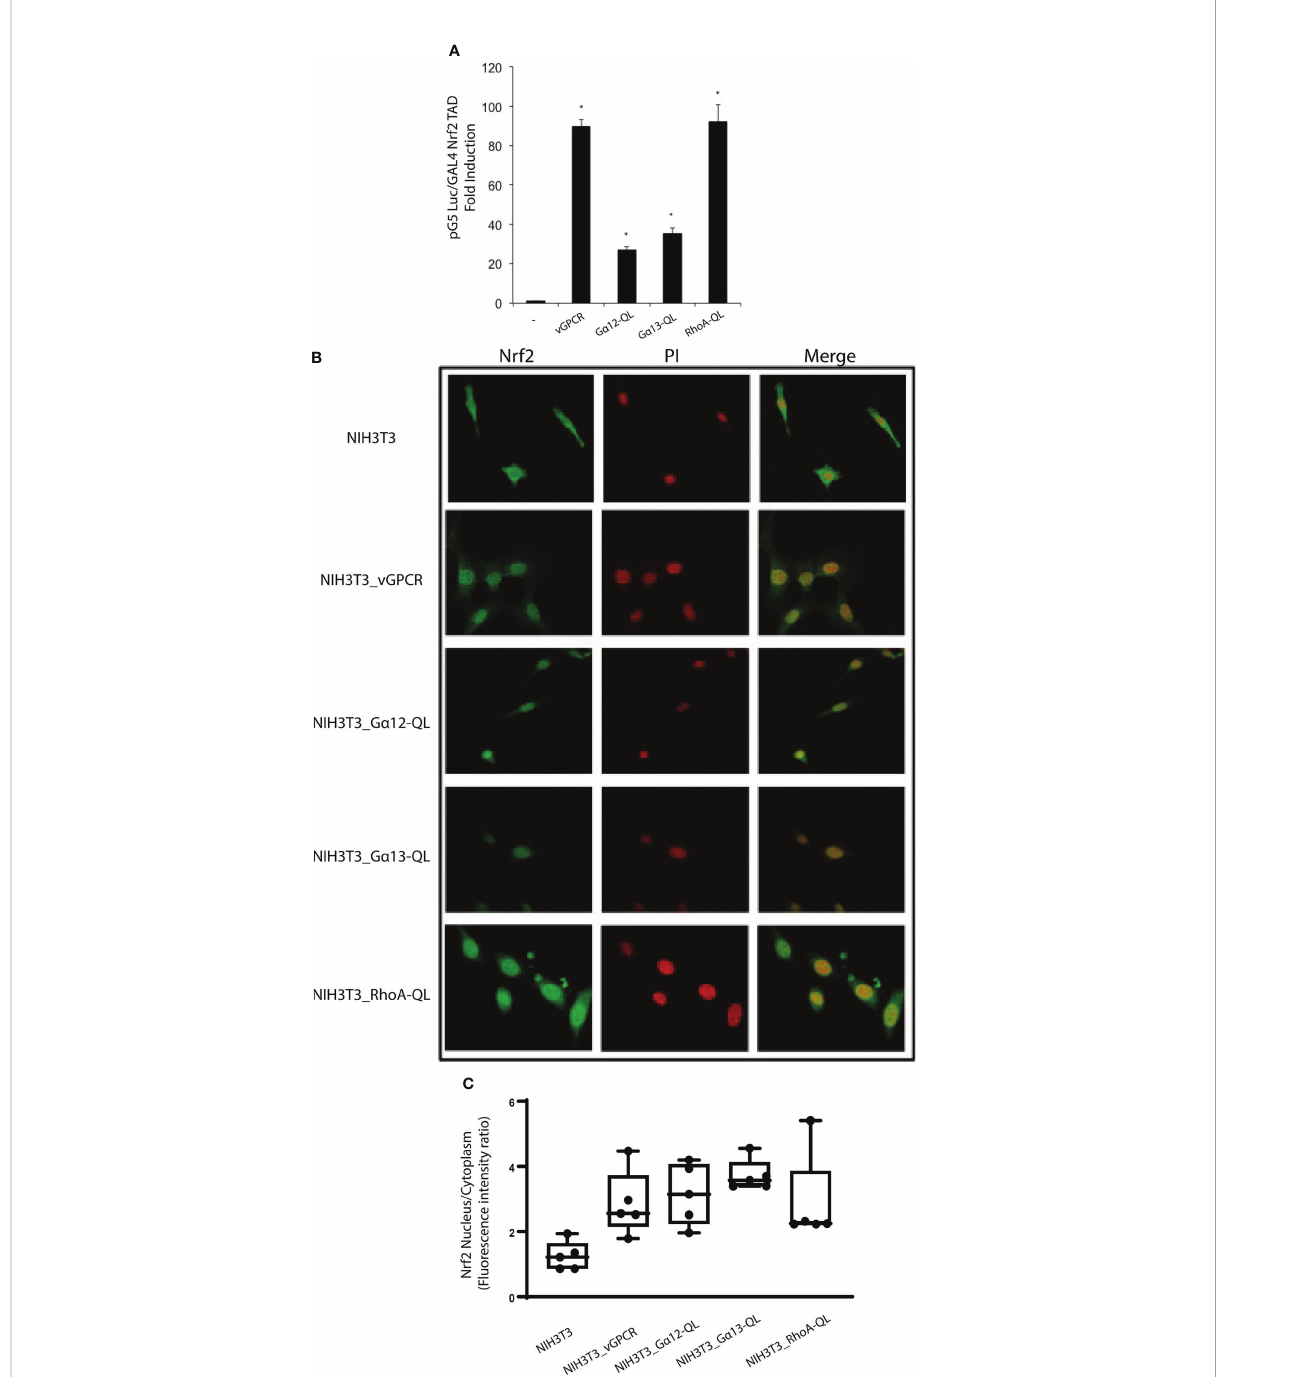
FIGURE 3 (A) Luciferase activity of the GAL4 reporter system to study transcriptional activation domains of transcription factors. pG5Luc and pGAL4_Nrf2TAD reporter plasmids were co-transfected with plasmids expressing vGPCR, G a 12-QL, G a 13-QL, and RhoA-QL. The results are expressed as fold induction relative to control cells (transfected with the reporter and an empty vector). (B) vGPCR, G a 12-QL, G a 13-QL, and RhoA-QL induced nuclear translocation of Nrf2. Confocal microscopy of NIH3T3 stable cell lines for the expression of vGPCR, G a 12-QL, G a 13-QL, and RhoA-QL were incubated with anti-Nrf2 and anti-rabbit FITC. For visualizing the nucleus, propidium iodide was used. Magni fi cation 40X. (C) Quanti fi cation of fl uorescence intensity for the nucleus/cytoplasm localization of Nrf2 in the different conditions from (B) . p-value < 0.05